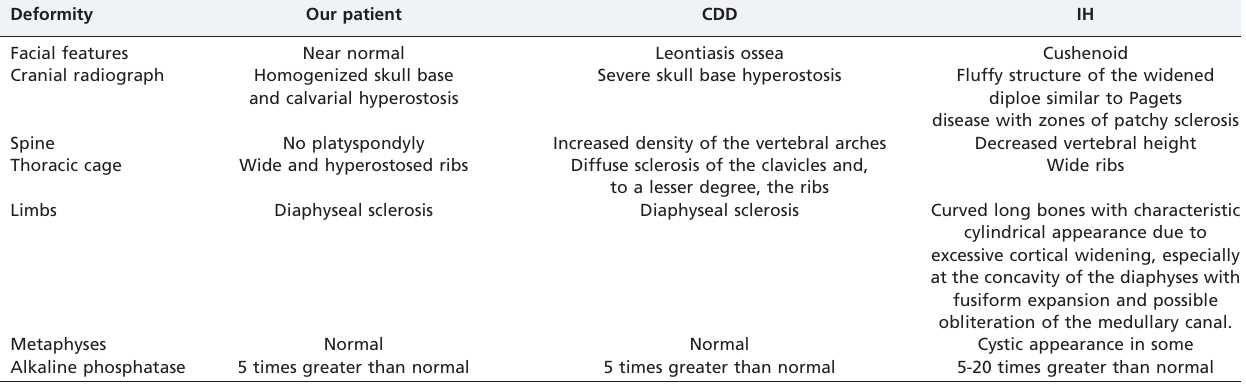
Table 1 - Comparison between features observed in our patients and those seen in patients with craniodiaphyseal dysplasia (CDD) and idiopathic hyperphosphatasia (IH).